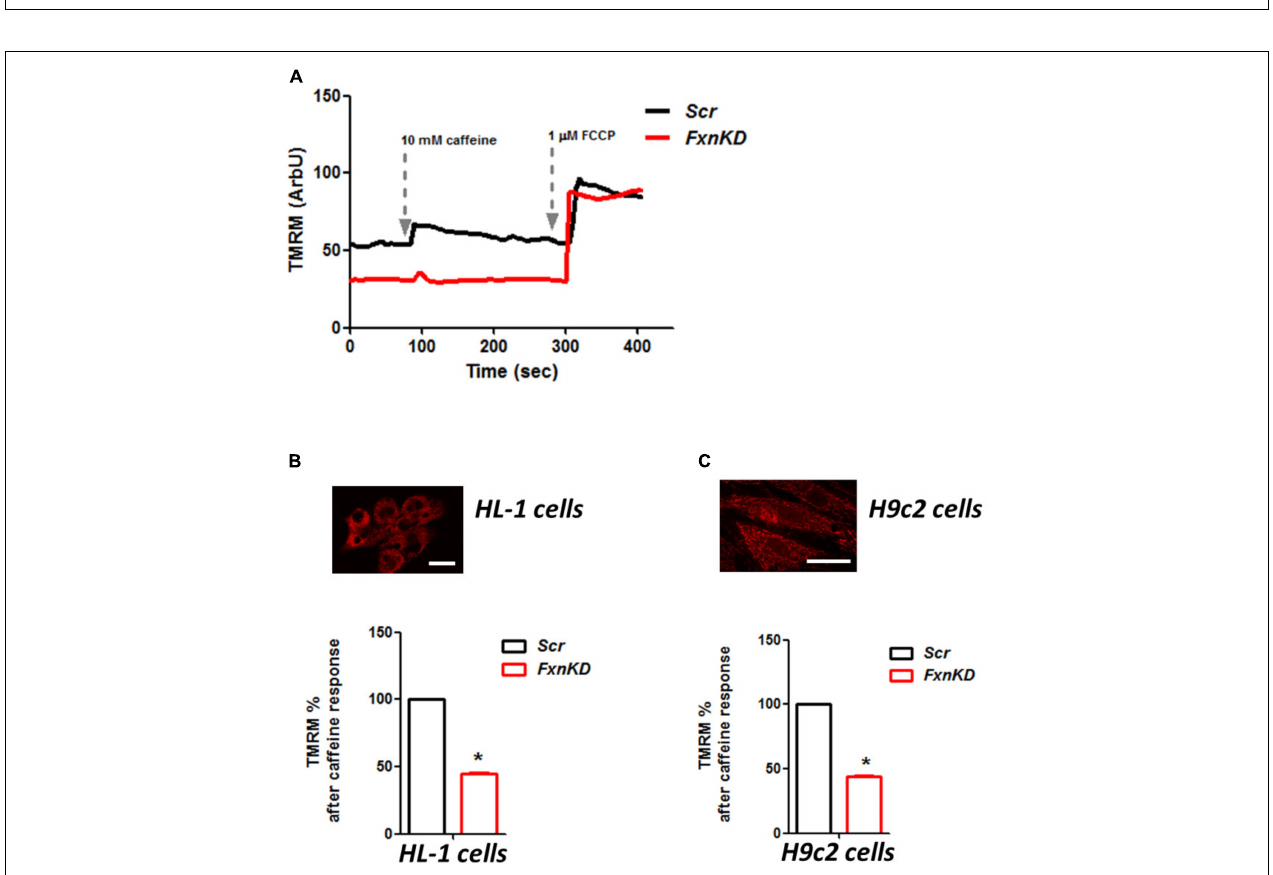
FIGURE 7 | FxnKD causes an abnormal energetic response to caffeine in cardiomyocytes. (A) TMRM was loaded in de-quence mode, at high concentration, where a depolarization of (cid:49)(cid:57) m is seen by an increase of fluorescence. The response to caffeine depolarises the potential as the mitochondria are active taking up Ca 2 + to restore the Ca 2 + homeostasis of the cell. (B,C) In FxnKD cells the response is reduced revealing that the mitochondria may not take up Ca 2 + correctly ( ∗ p < 0.05). Scale bar (20 µ m).